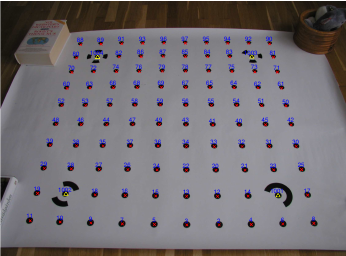
Figure 1: An input image with measured coordinates.